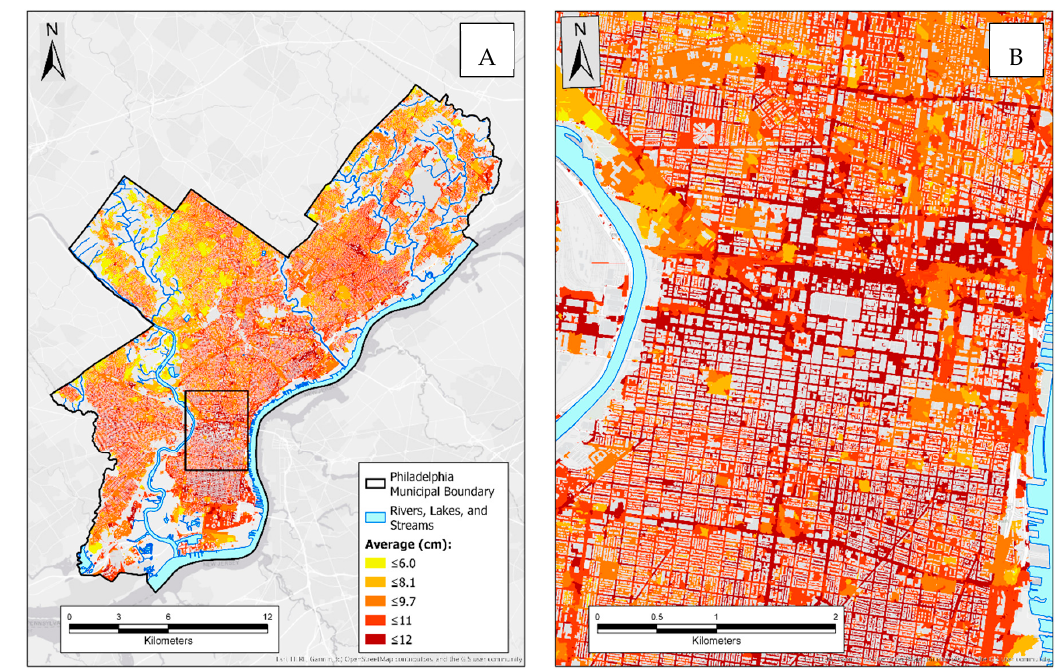
Figure 8. The average index map shows the average runoff depth estimated by the NRCS and modified rational models for 24-hour, 10-year storm for city of Philadelphia ( A ) and Center City ( B ).